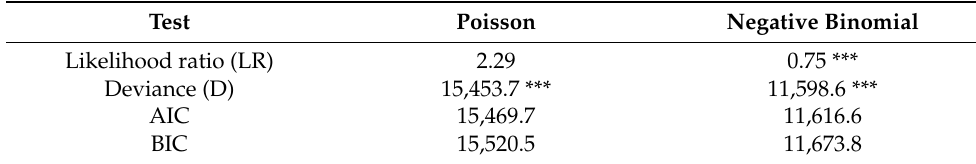
Table 4. Statistics of goodness of fit for fitted count regression models.